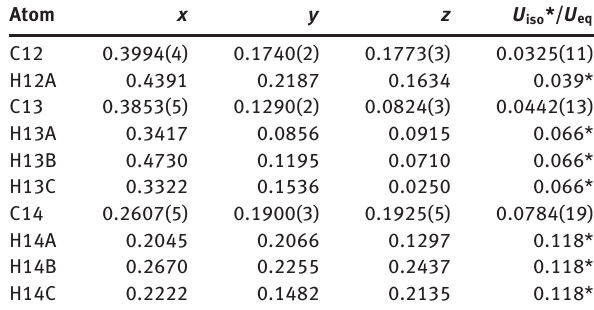
Table 2: Fractional atomic coordinates and isotropic or equivalent isotropic displacement parameters (Å 2